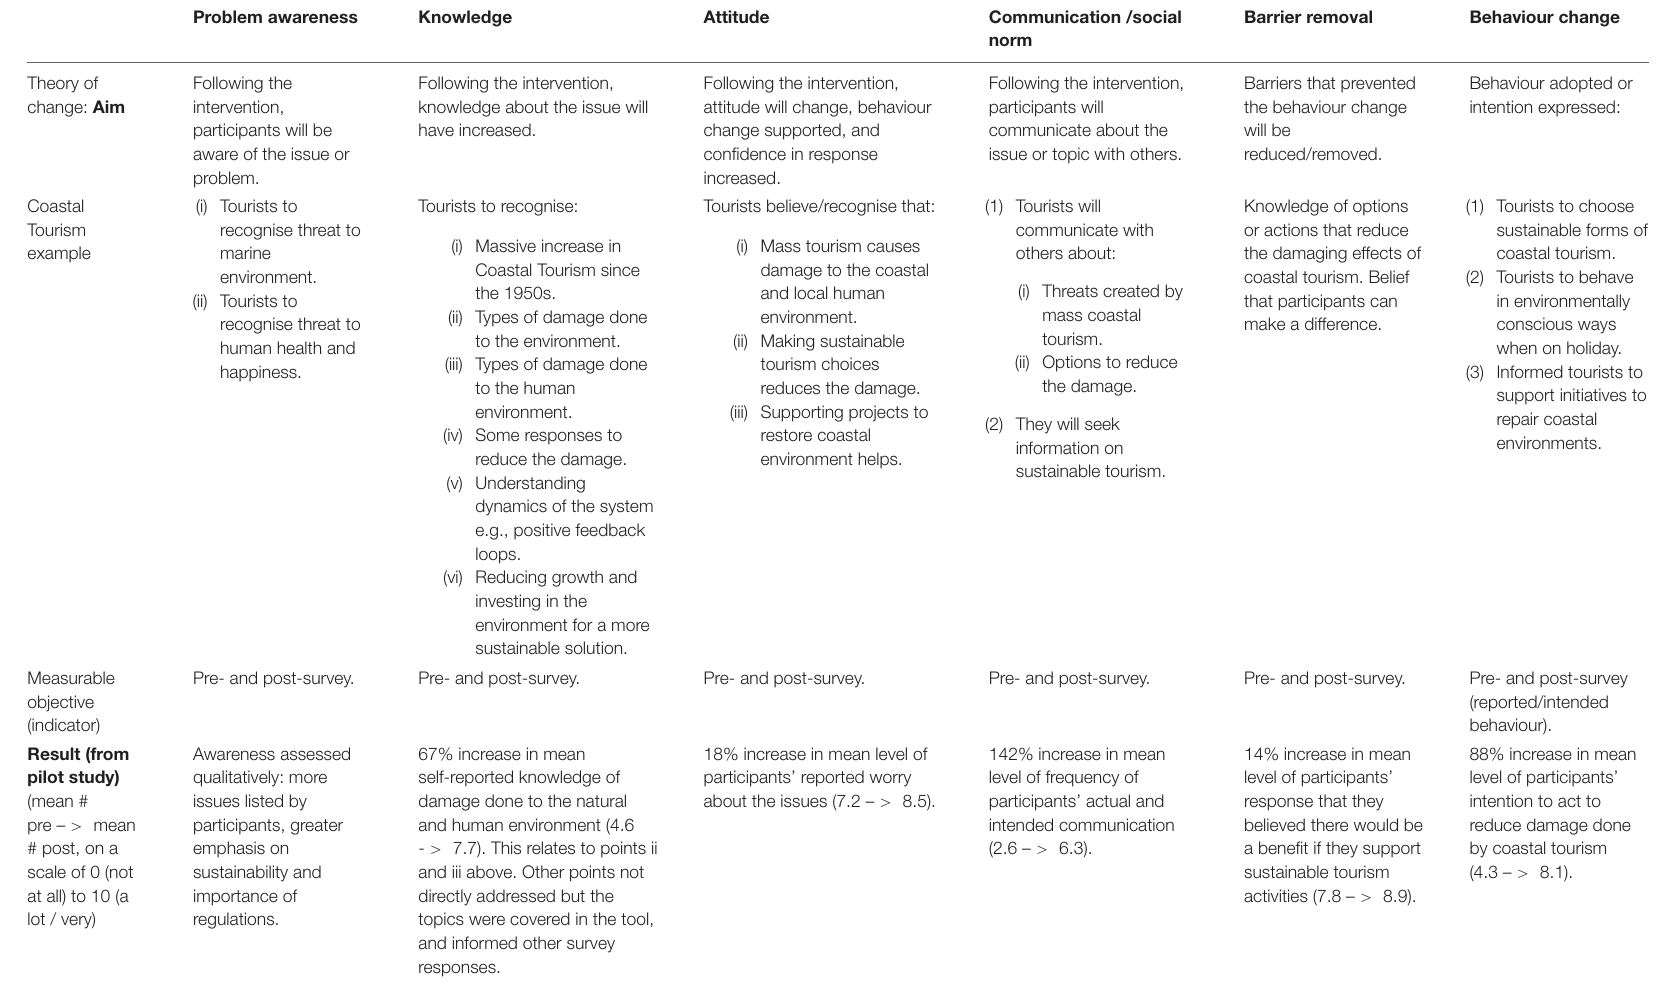
TABLE 4 | Theory of change logic model developed to assess effectiveness of OL tool. Problem awareness